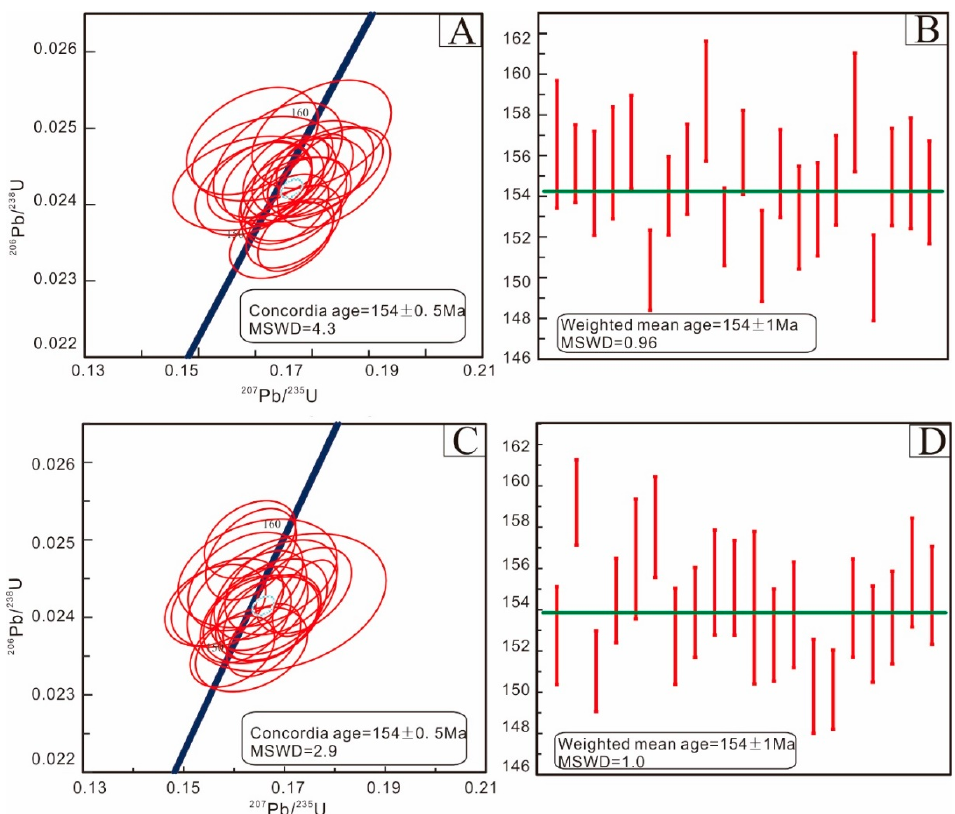
Figure 5. The LA-ICP-MS zircon U–Pb concordant curves and weight mean values for granite porphyries in the Jiangjiatun Mo deposit. ( A ) The LA-ICP-MS zircon U–Pb concordant curves of sample 511-16; ( B ) The LA-ICP-MS zircon U–Pb weight mean values of sample 511-16; ( C ) The LA-ICP-MS zircon U–Pb concordant curves of sample 511-27; ( D ) The LA-ICP-MS zircon U–Pb weight mean values of sample 511-27. Table 1. LA-ICP-MS zircon U–Pb dating data of granite porphyries in the Jiangjiatun Mo deposit (sample Number 511-16 and